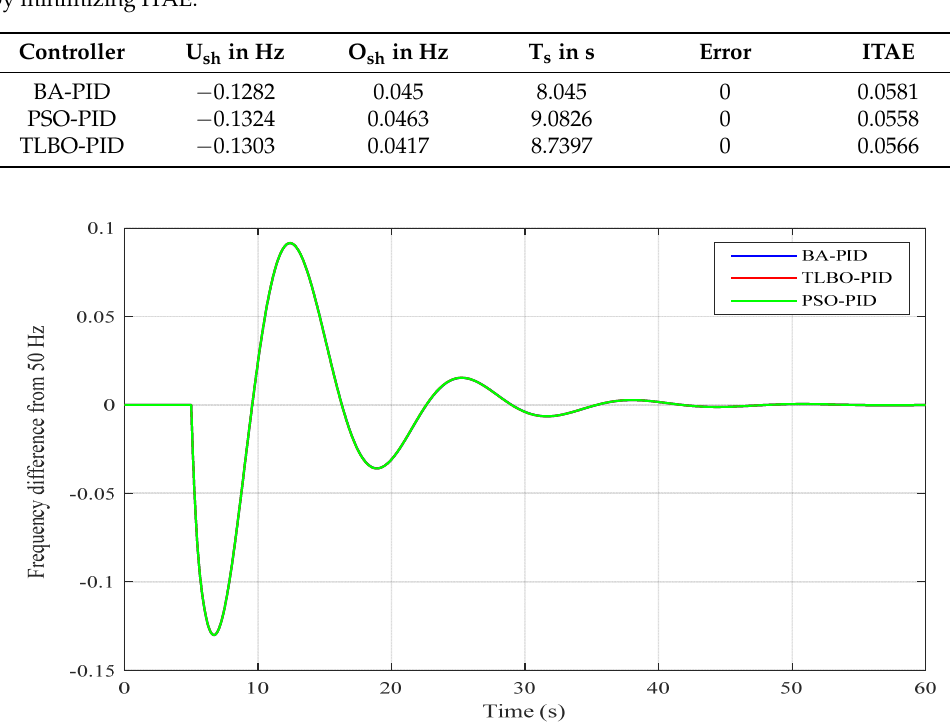
Figure 7. Change in frequency in the GB power system for 0.035 pu load disturbance with tuned PID-based ITAE.